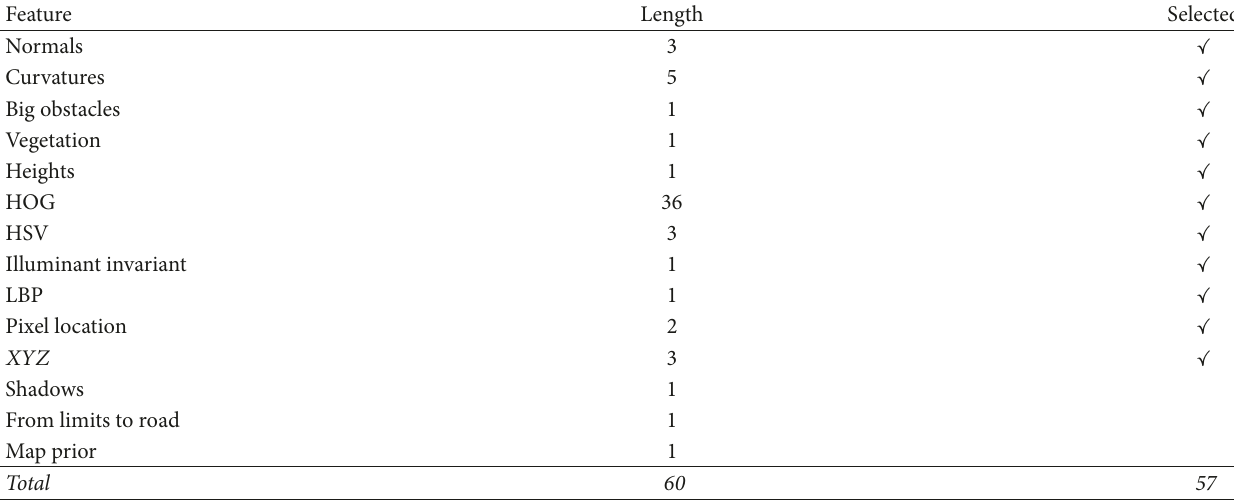
Table 4: Basic feature selection for the classifier parameters